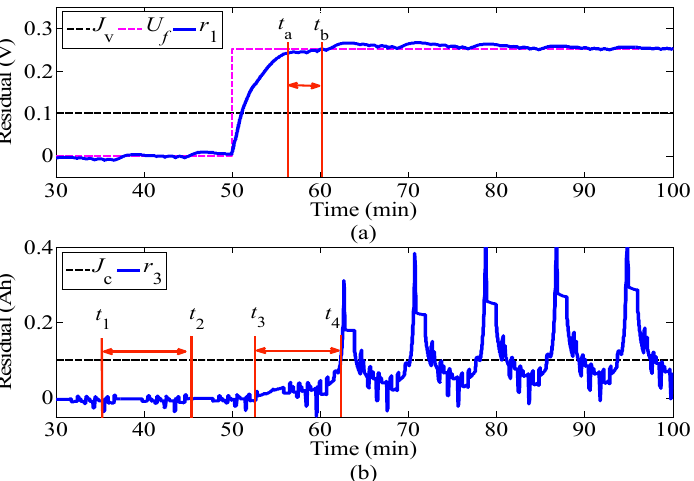
Figure 10. Residual responses for sensor faults: ( a ) r 1 for a voltage sensor fault; ( b ) r 3 for a current sensor fault.